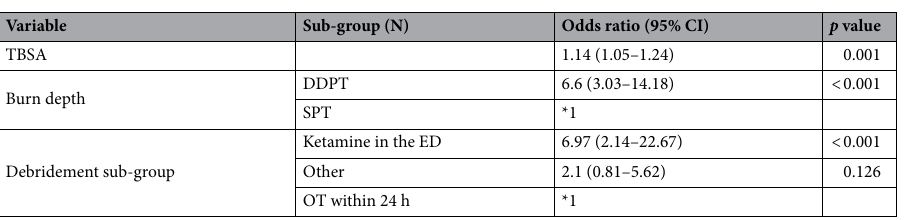
Table 3. Odds of grafting following non-excisional debridement n = 292. DDPT deep dermal partial thickness, SPT superficial partial thickness, TBSA total body surface area, ED emergency department, OT operating theatre, CI confidence interval. *1 = reference group for